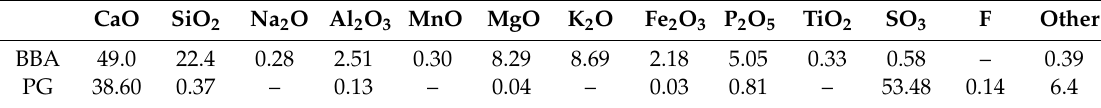
Table 1. Chemical composition of initial materials, wt%.